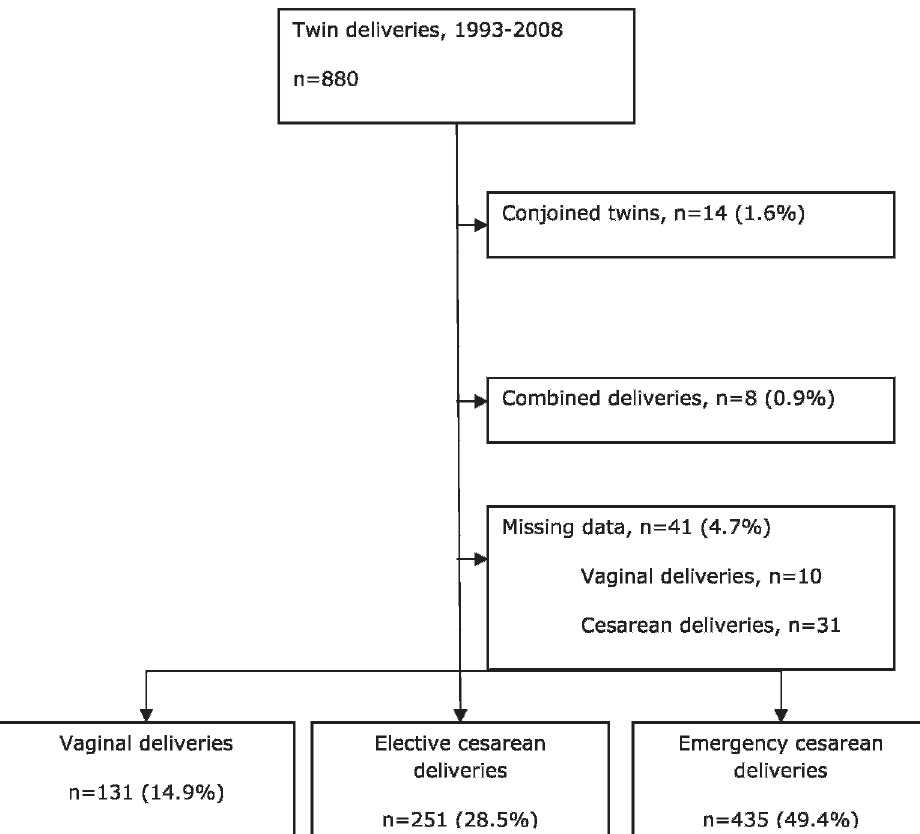
Figure 1 - Historical cohort of twin pregnancies delivered at the Hospital das Clı´nicas, Sa˜o Paulo University Medical School, Brazil between 1993 and 2008.